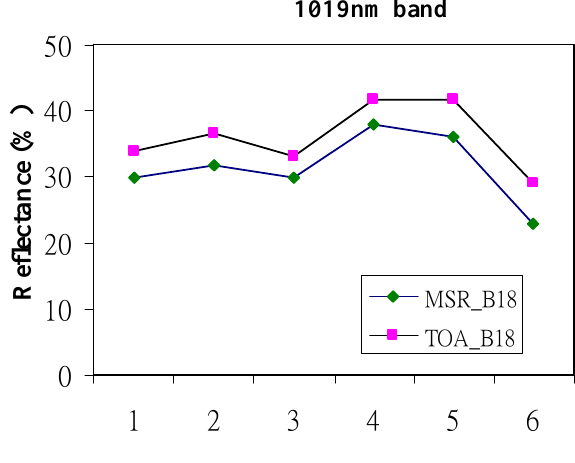
Figure 2 . Comparison of MSR reflectance at 6 forest ground sites with TOA reflectance for CHRIS 1,019 nm band. Mean difference is 3.3%. 1019nm